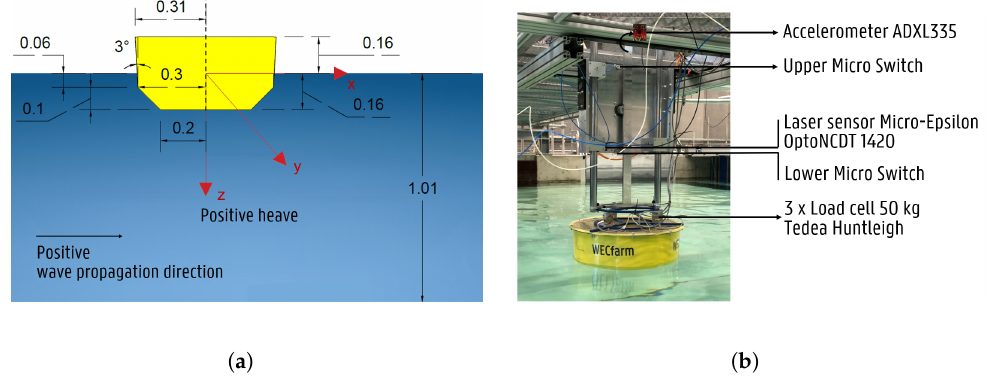
Figure 2. ‘WECfarm’ WEC: ( a ) 2D rendering of the WEC buoy, dimensions in m; ( b ) sensors and their respective location on the